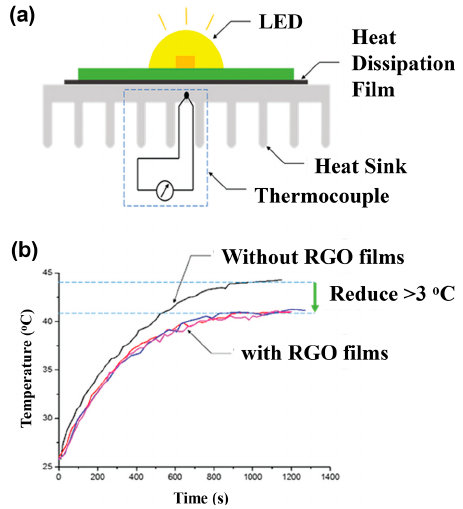
Figure 9. ( a ) Schematic plot of the temperature measurement model of a 7 W LED as the hot spot with and without rGO films. ( b ) Real-time temperature profile of the LED hot spot with and without rGO films. Reprinted from [63] with permission; Copyright 2017 Royal Society of